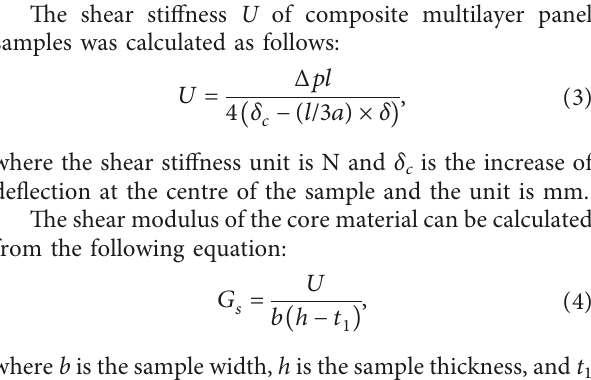
Figure 4: Three-point bending test